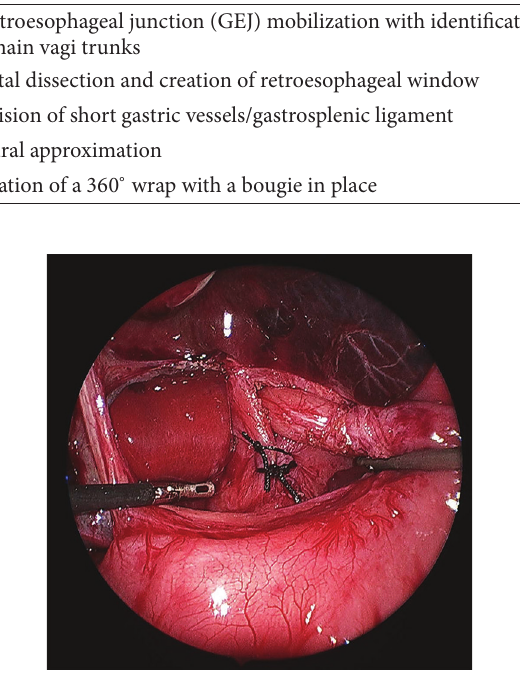
Figure 1: Laparoscopic Nissen fundoplication technique. Esophageal mobilization with creation of a retroesophageal window and crural approximation (sutures).